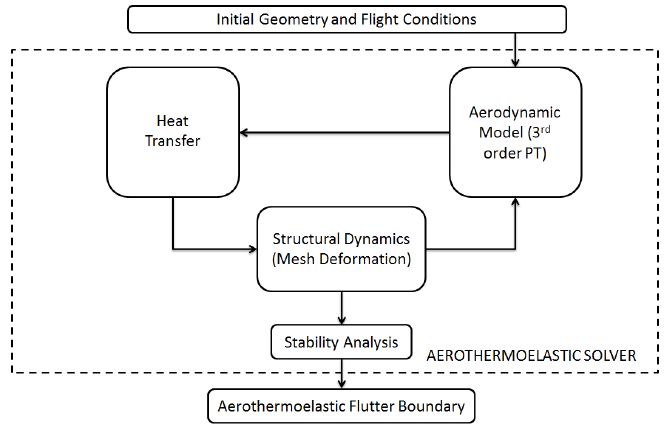
Figure 5. Aerothermoelastic